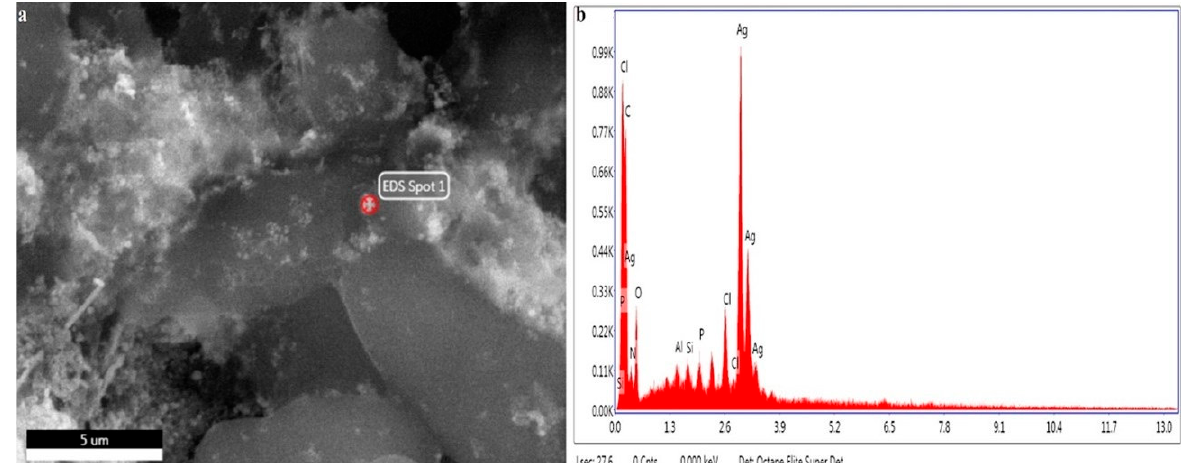
Figure 5. EDX analysis of AgNPs, ( a ) EDX micrograph, ( b ) EDX spectrum of AGNPs synthesized from Elaeagnus umbellata fruit extract. Table 2. Elemental analysis of AgNPs synthesized from Elaeagnus umbellata fruit